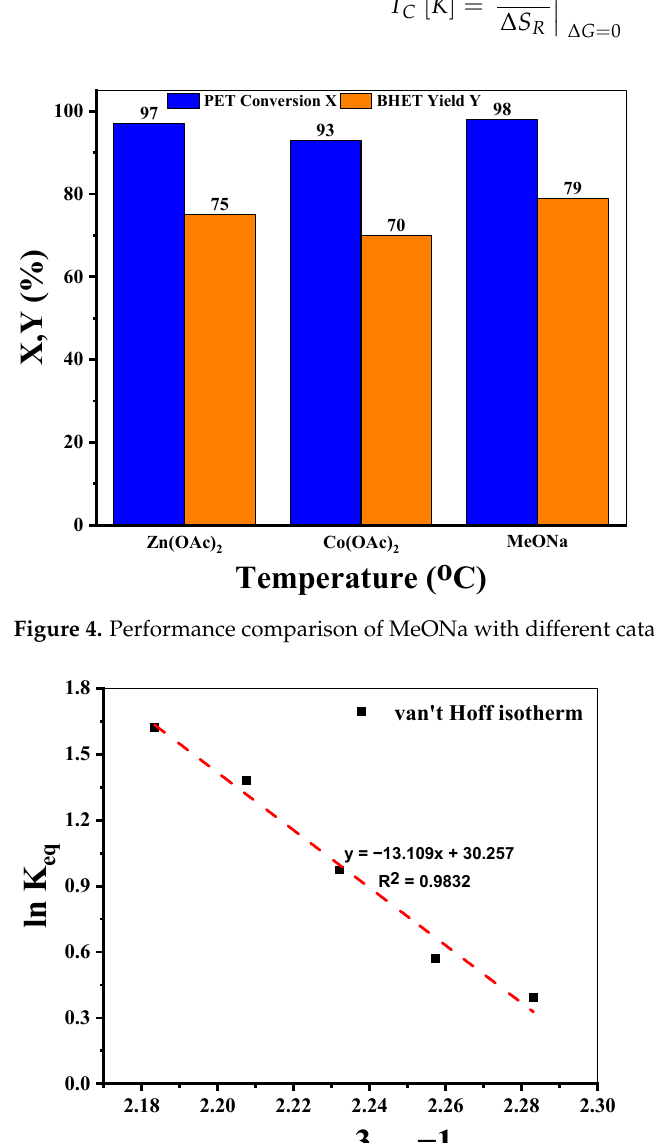
Figure 4. Performance comparison of MeONa with different catalysts .